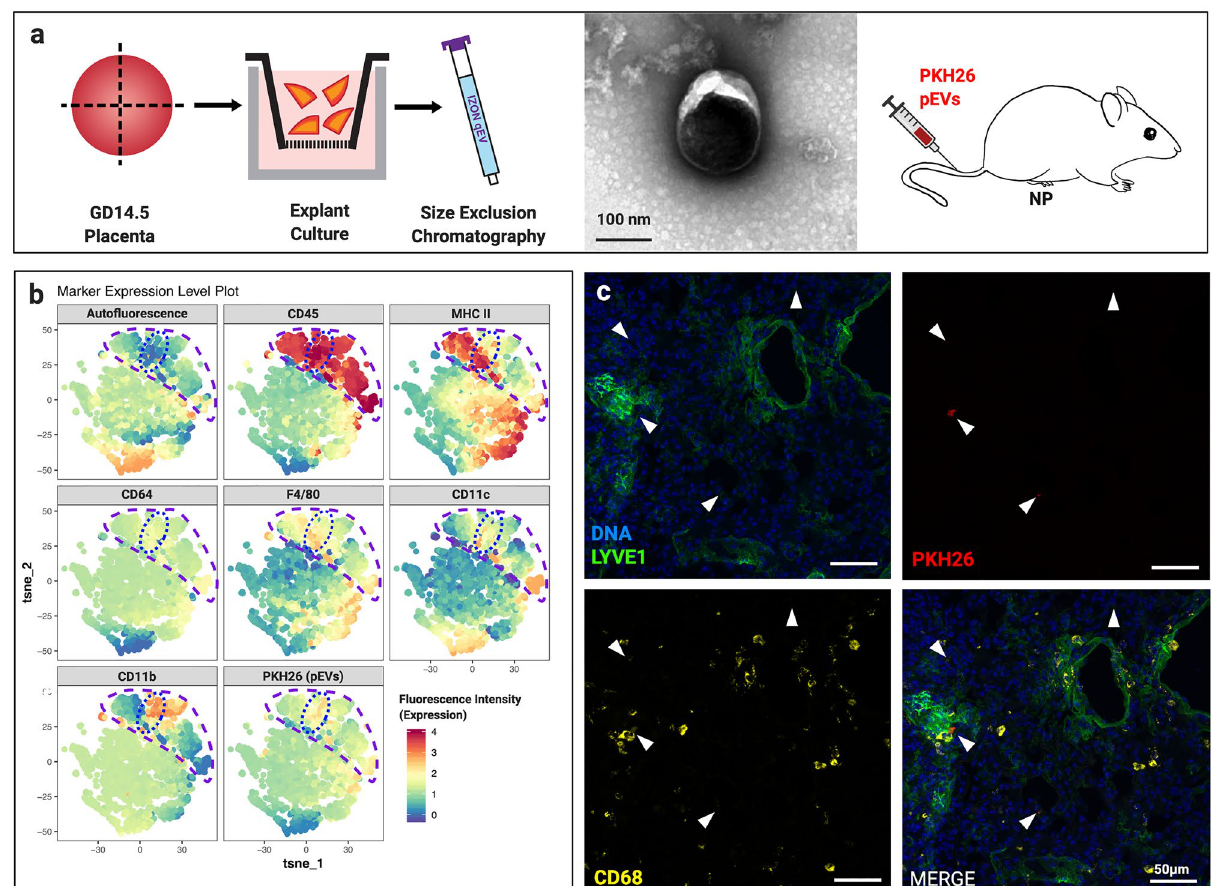
Figure 2. Placental EV trafficking in vivo. ( a ) EVs were purified from the medium of GD14.5 placental explants; a representative TEM is shown. After labeling with PKH26, 2.5 × 10 10 EVs were administered i.v. into nonpregnant females. After 30 min mice were sacrificed, and lung and liver harvested and processed for downstream analysis. ( b ) t-SNE analysis of dispersed and murine lung cells after treatment of mice with GD14.5 placental EVs. Cell suspensions were stained with the fluorophore-conjugated antibodies indicated above each panel and analyzed by flow cytometry. Experiments shown is representative of seven independent experiments. ( c ) Immunofluorescence microscopy of lungs from mice treated with GD14.5 placental EVs. Arrows, pEV foci (red), one of which in this image colocalizes with LYVE1 (green) and CD68 (yellow). Representative images of five random fields per animal; n = 7 in three independent